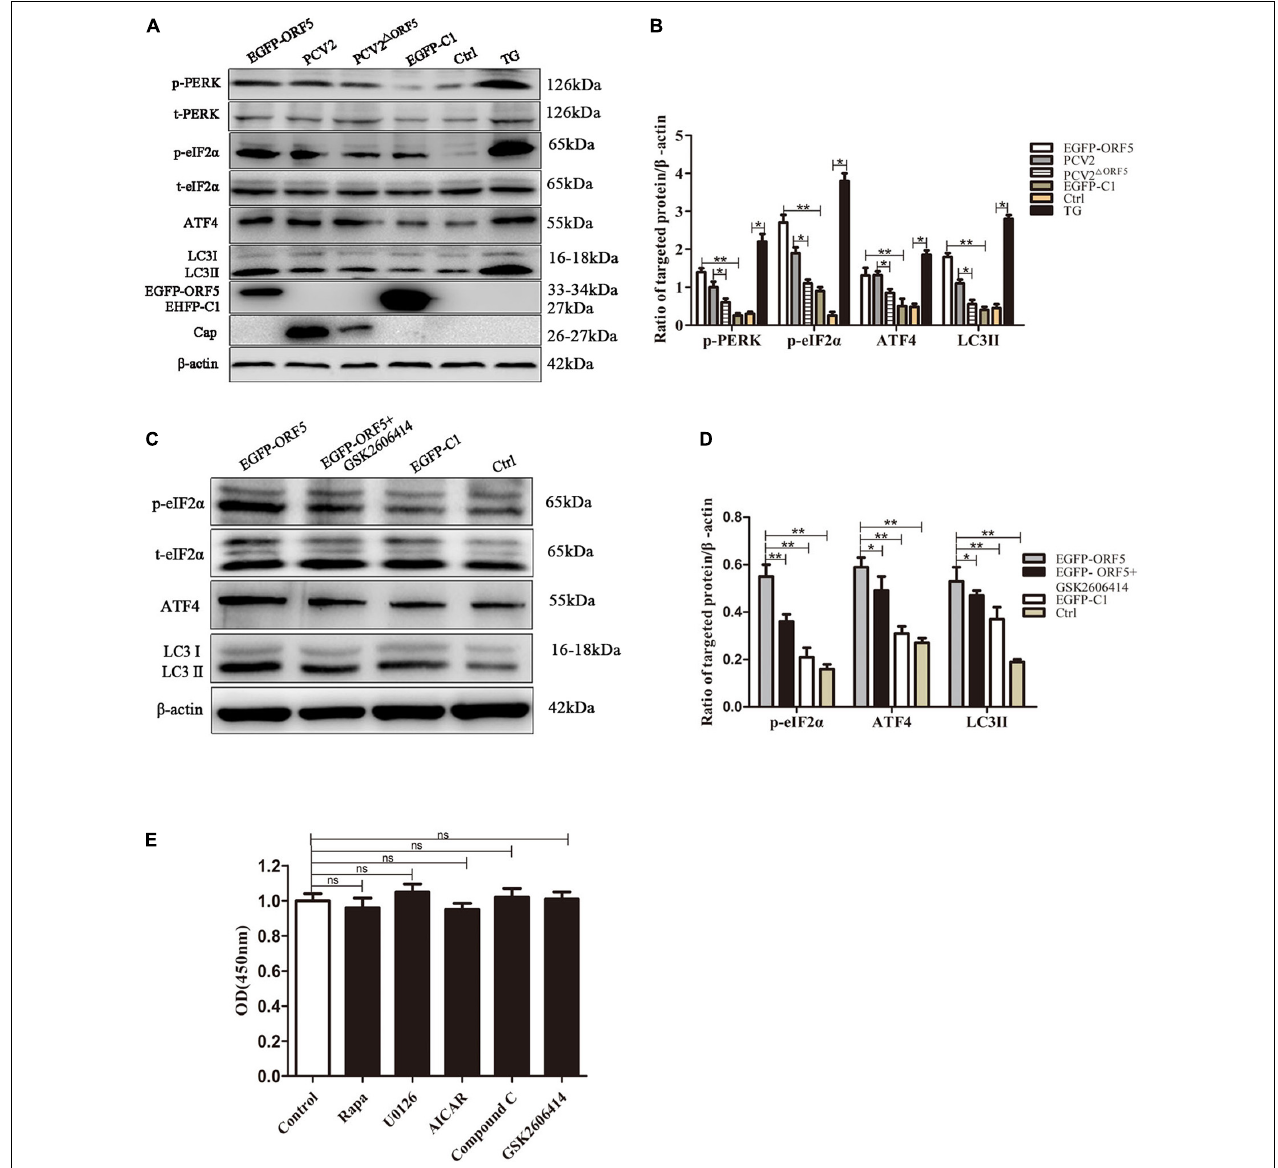
FIGURE 2 | ORF5 protein induces autophagy by PERK-eIF2 α -ATF4. (A) PK-15 cell transfected with EGFP-ORF5 or infected with PCV2 and PCV2 (cid:49) ORF5 for 36 h. p-PERK, t-PERK, p-eIF2 α , t-eIF2 α , ATF4, LC3II were detected by immunoblotting. (B) T -test on the grayscale analysis of the (A), the ratio of targeted protein to β -actin. (C) PK-15 cells were treated with GSK2606414 (1 µ M), p-eIF2 α , t-eIF2 α , ATF4, and LC3II were detected by immunoblotting. (D) T -test on the grayscale analysis of the (C) , the ratio of targeted protein to β -actin. (E) MTT detects the effect of various chemical treatments on cell viability. All chemical solvents are DMSO (DMSO < 1%). Control only added DMSO (DMSO < 1%) as a negative control. ns, p > 0.05 versus the control group. * p < 0.05, ** p < 0.01. ns, not